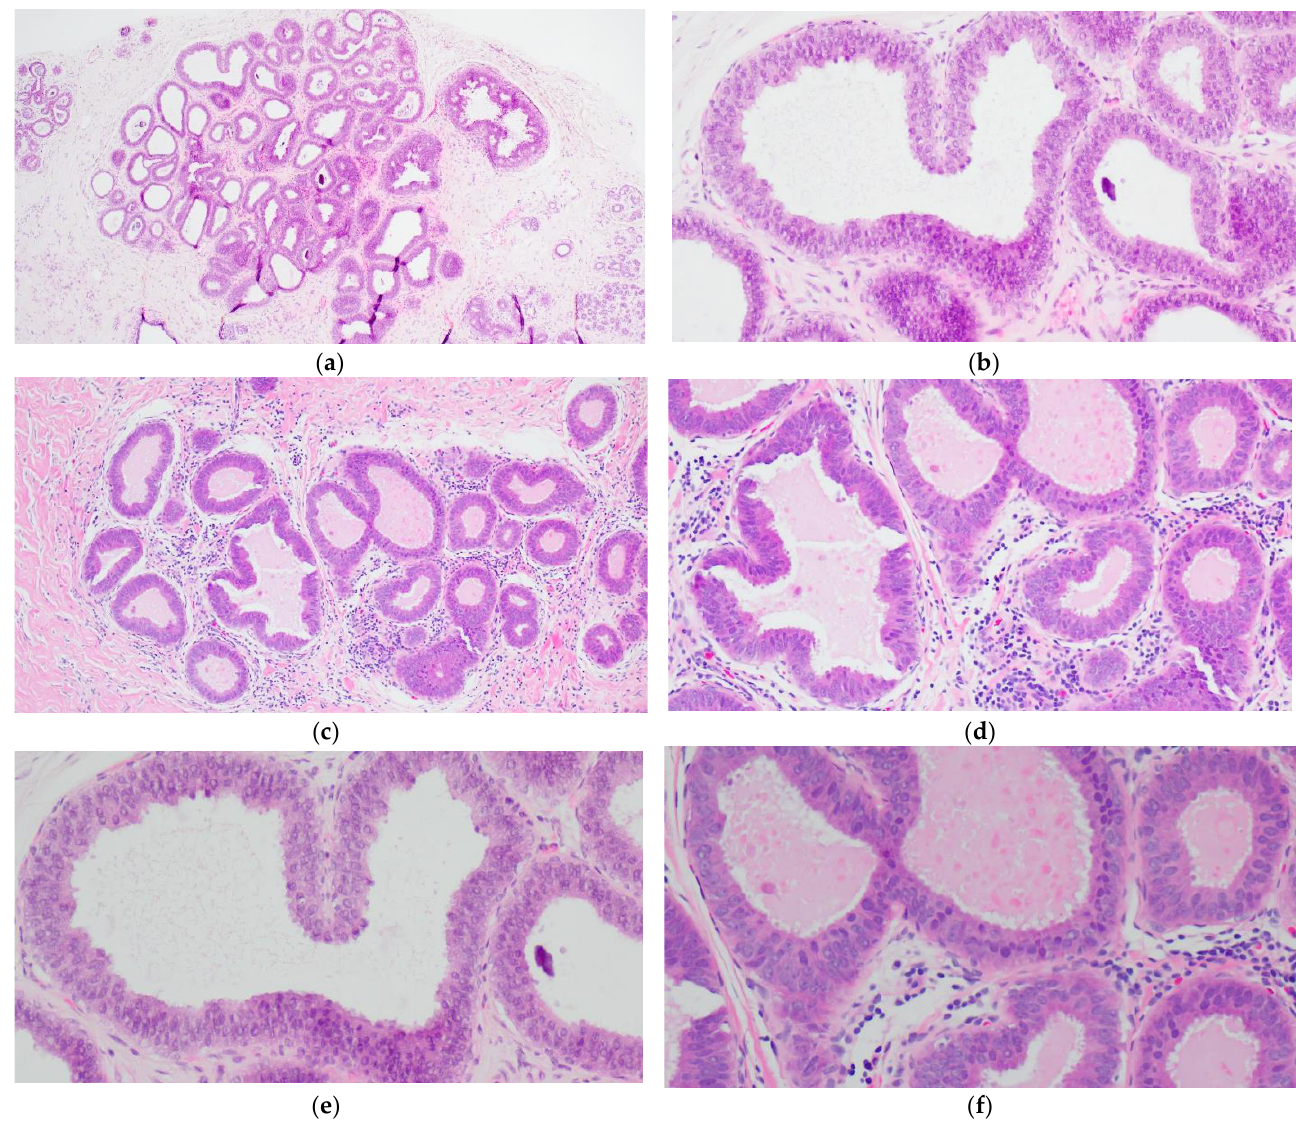
Figure 3. Flat epithelial atypia (FEA) composed of variably dilated acini ( a , c ) with calcifications ( a , b ) and low-grade cytologic atypia characterized by the presence of rounded or ovoid nuclei with loss of polarity, mildly increased nuclear to cytoplasmic ratio and prominent nucleoli in some cells ( b , d – f ). Several authors have examined morphometric nuclear features in order to aid in the distinction of FEA from CCC. Using whole slide imaging and ImageJ software Katayama et al. compared morphologic parameters of 12 cases of CCC and FEA [60]. While cells in CCC had greater mean maximum Feret’s diameter (defined as the measure of an object size along a specified direction), major axis length and perimeter, cells in FEA had larger mean minimum Feret’s diameter, minor axis lengths and nuclear area. The nuclei of FEA also showed a significantly rounder shape as compared to nuclei of CCC. Similarly, in a cohort of 22 FEAs and 13 CCLs without atypia, Yamashita et al. used ellipticity as a nuclear